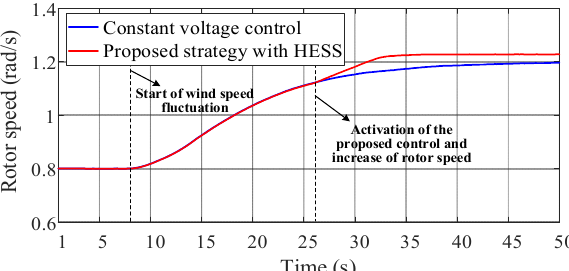
Figure 14. The rotor speed of the DFIG in case I.